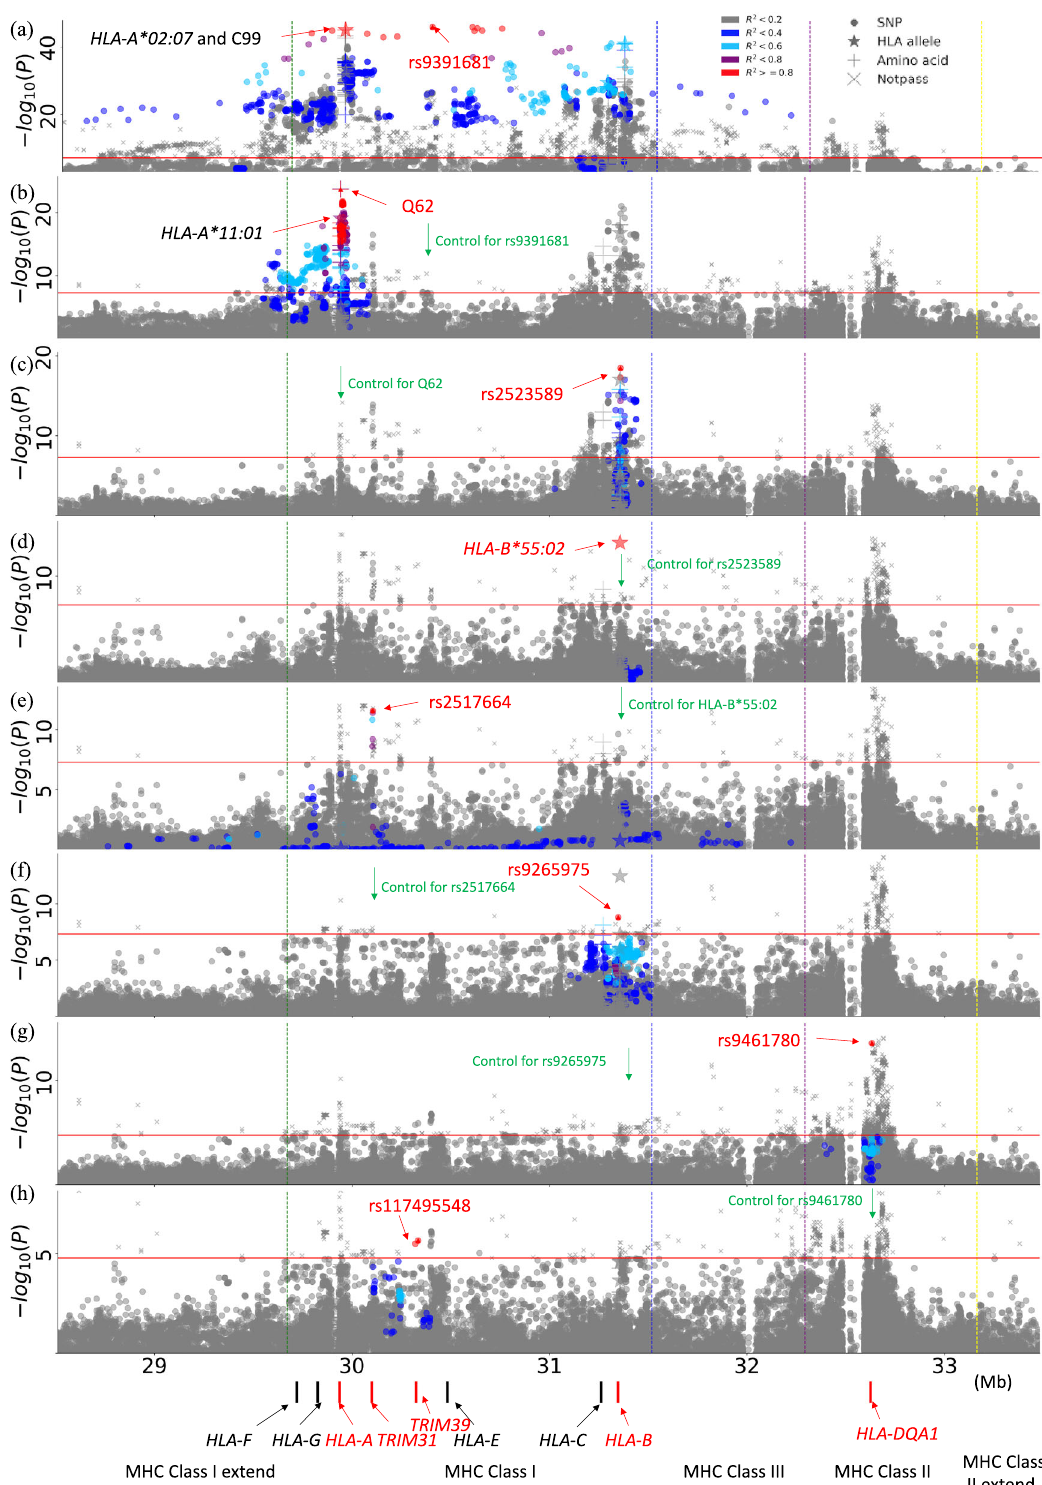
Fig. 1 Manhattan plots of the forward conditional association of the variants in HLA region for NPC risk. a This panel shows the original association. Other panels show the association while controlling the locus b rs9391681, c HLA-A aa-Q62 , d rs2523589, e HLA-B*55:02 , f rs2517664, g rs9461780, h rs117495548. The horizontal axis shows the genomic position and the vertical axis shows negative log 10 -transformed P for the association. The red horizontal line corresponds to the signi fi cance threshold of P = 5 × 10 − 8 . SNPs (dots), HLA alleles (stars), and amino acid polymorphisms ( + ) are marked in the plots. The color of the variant represents the r 2 between this variant and the controlled